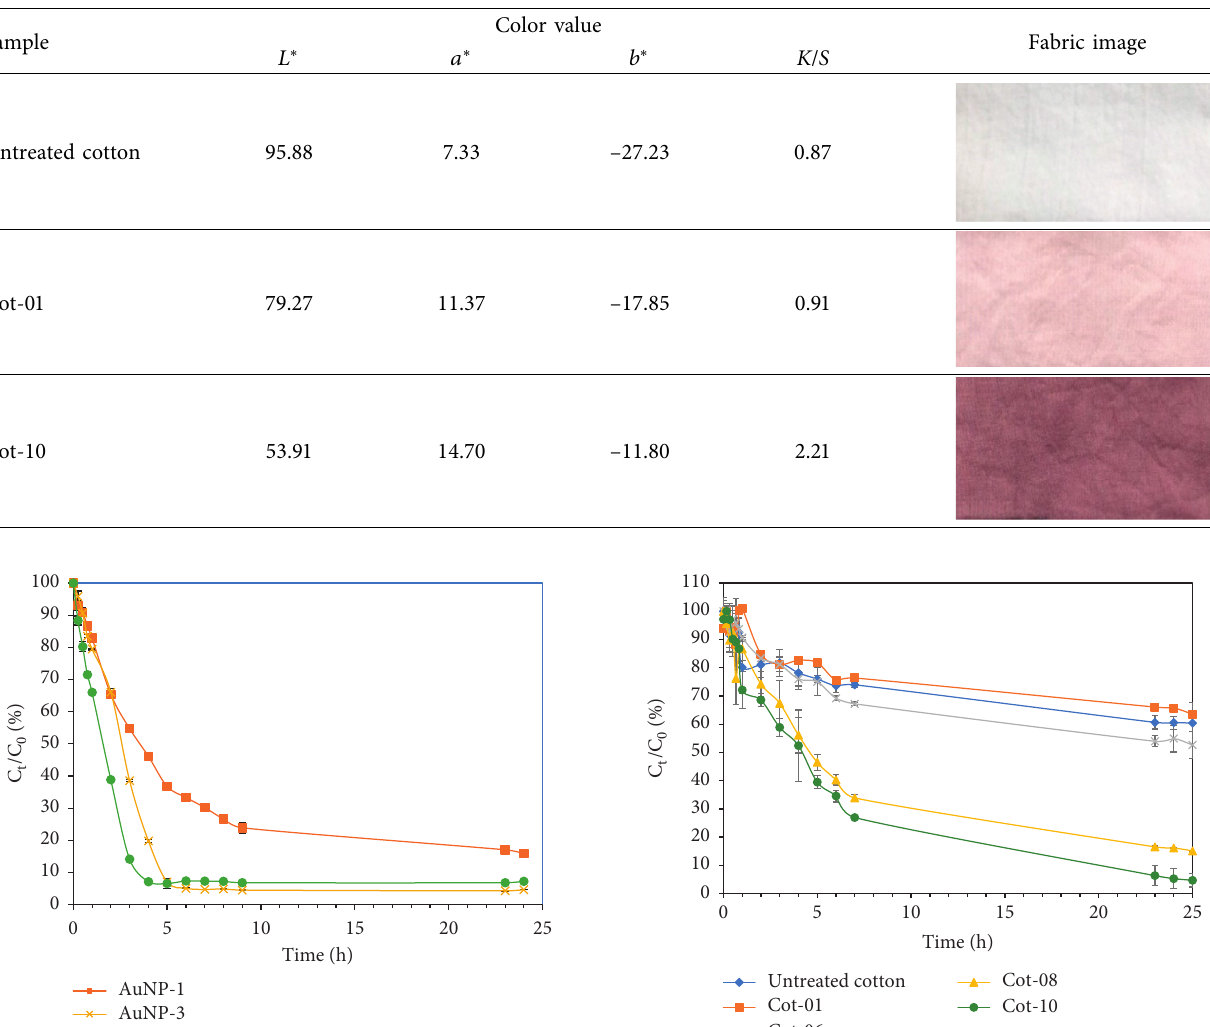
Table 1: Color values and photographic images of AuNP-coated cotton fabrics.